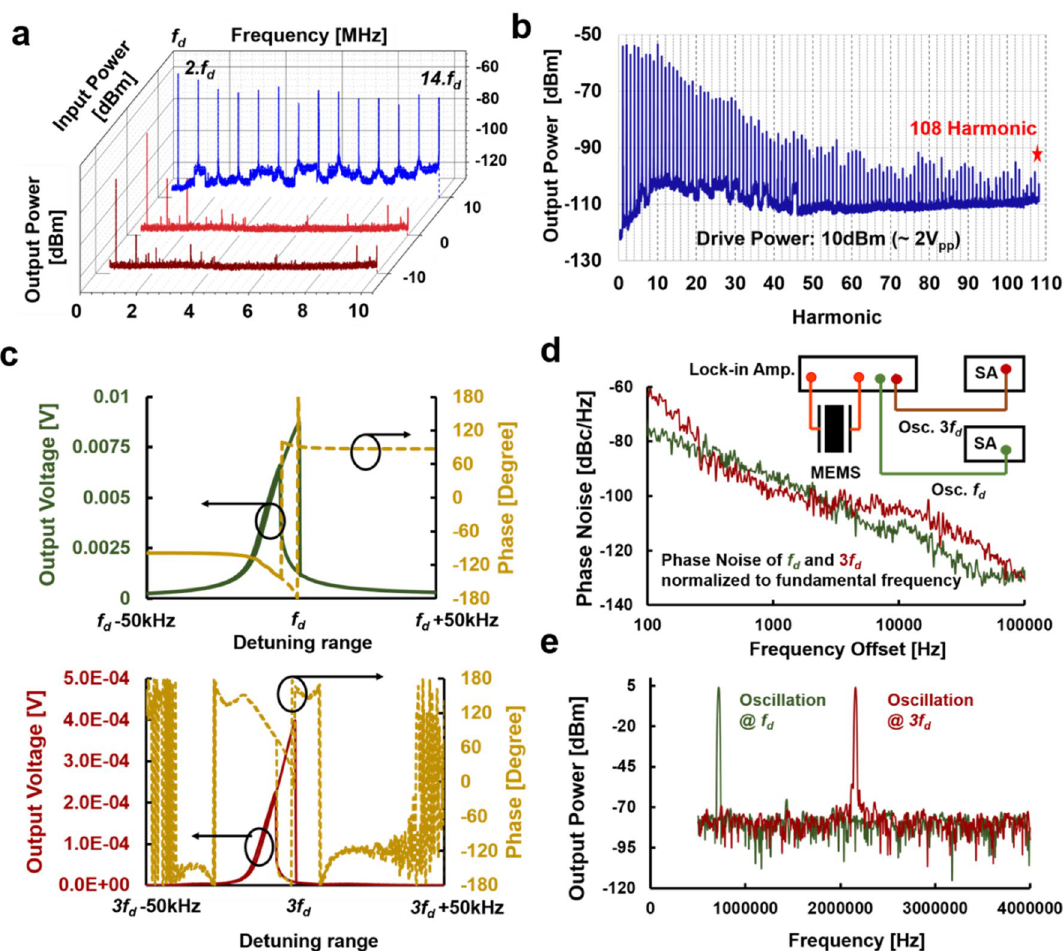
Figure 4. SIMO Frequency Synthesizer. ( a ) Output spectra of HHG for a single tone frequency input. The SA BW is set to 11 Hz for a better SNR. The number and strength of the harmonics are enhanced when the drive power is increased. ( b ) The electrical output spectrum for Device B when the resonator is driven at a frequency corresponding to the maximum range of nonlinearity. Reduced dynamic stiffness and increased